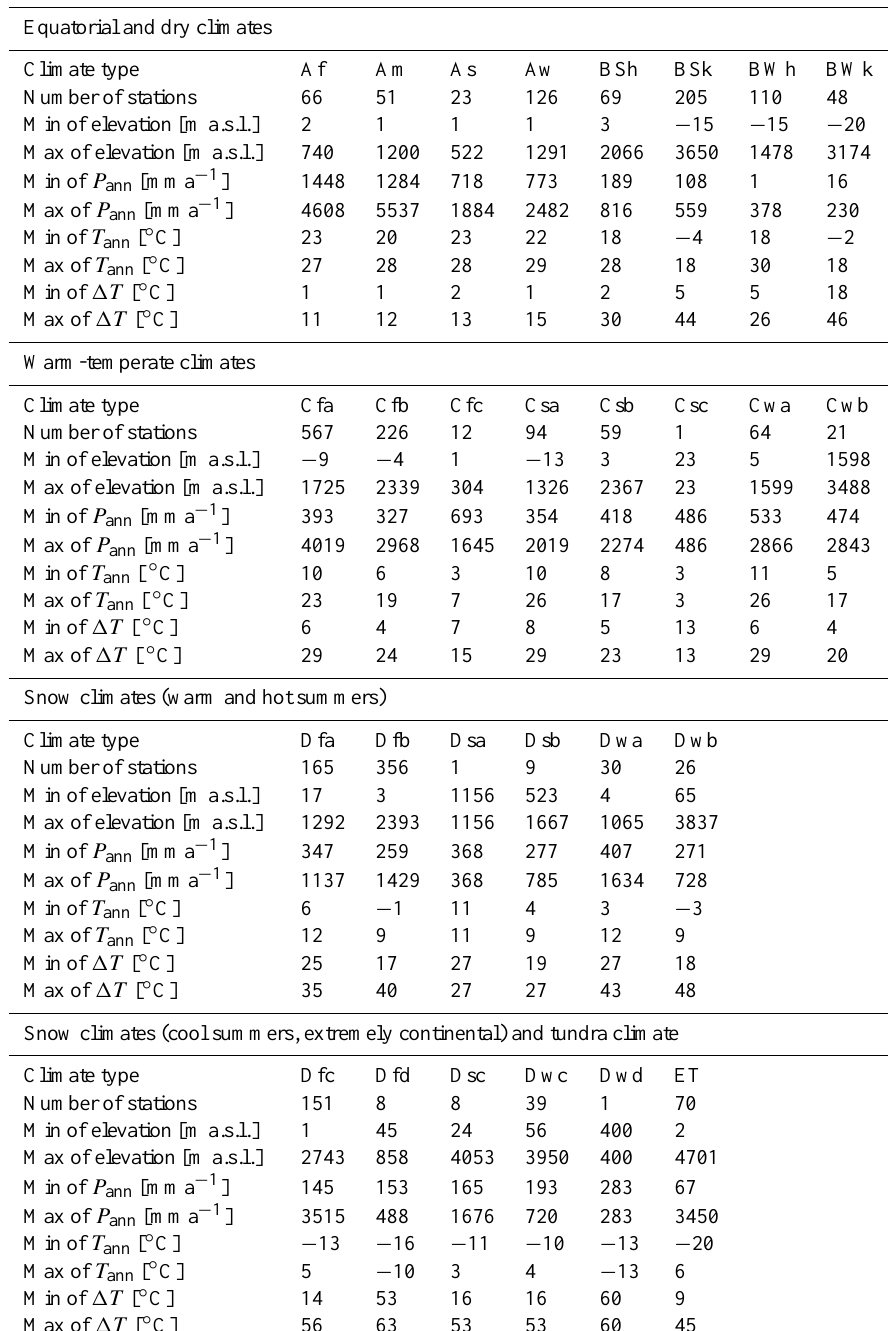
Table 3. Ranges of individual climate parameters of selected Köppen climate types for the Northern Hemisphere (compiled from Lieth et al.,